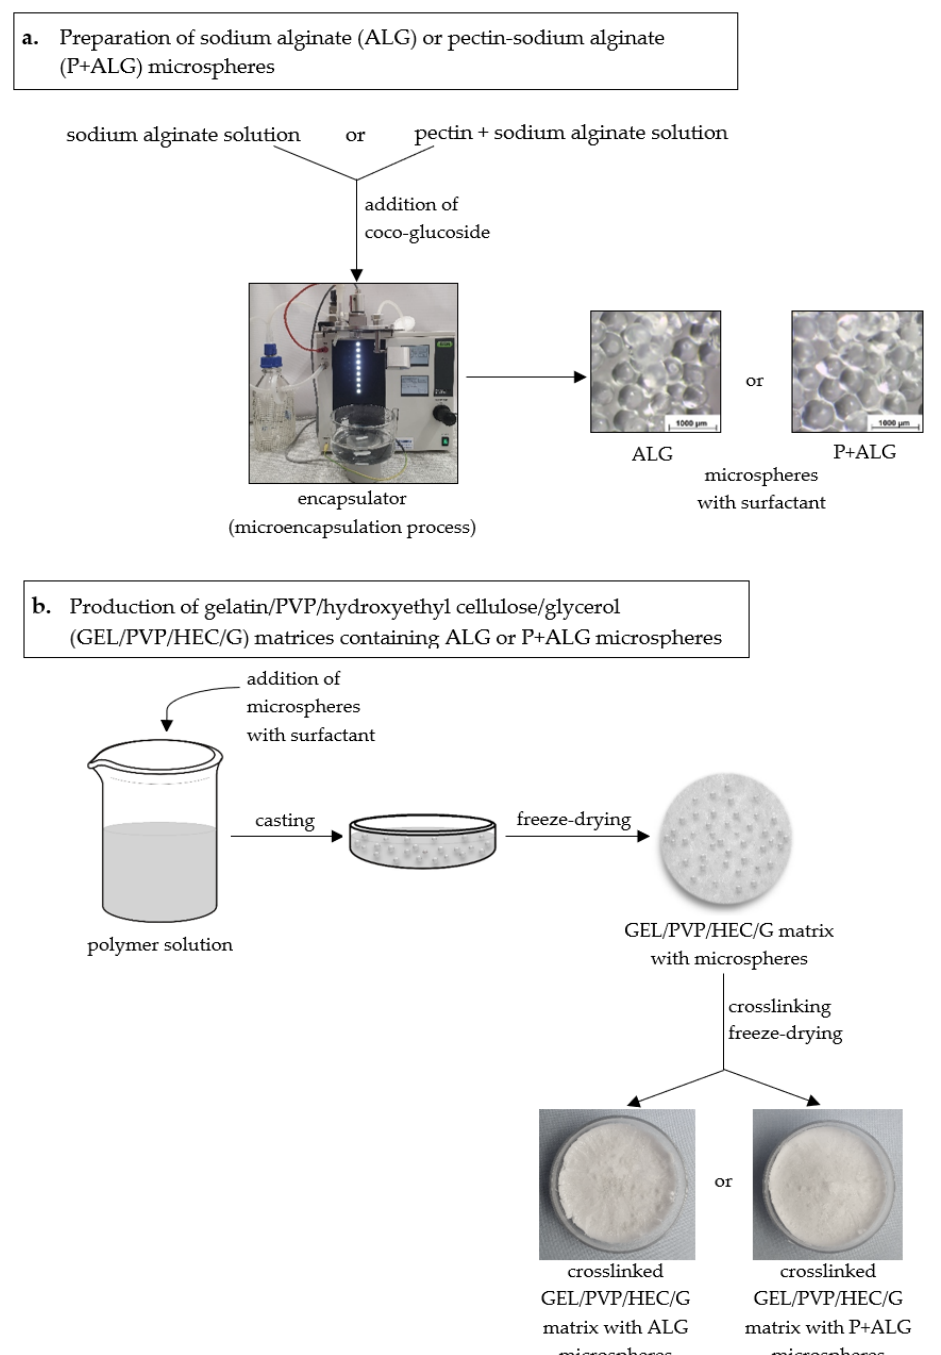
Figure 1. The scheme of preparation of sodium alginate and pectin-sodium alginate microspheres ( a ) and production of gelatin/PVP/hydroxyethyl cellulose/glycerol matrices with microspheres ( b ).